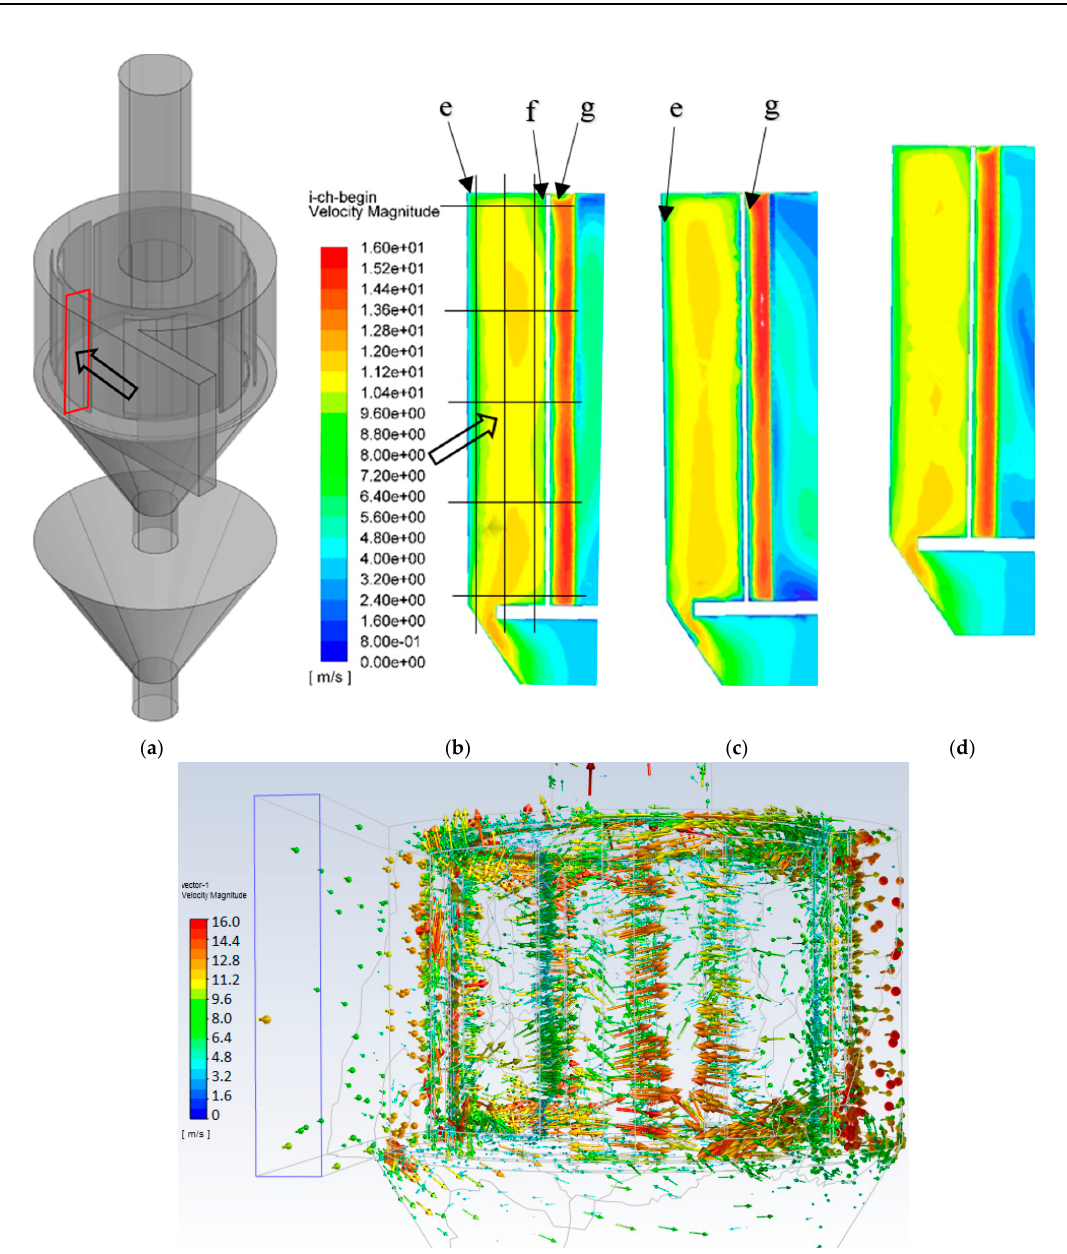
Figure 3. Rate distribution of the gas flow in the developed k ‐ ω SST viscosity model of the multi ‐ channel cyclone separator with a single inlet opening ( a ) at the beginning of the first channel, given for minimally ( b ), moderately ( c ) and maximally ( d ) detailed computational meshes: ( e ) is the wall layer by the peripheral wall; the wall layer near the outer ( f ) and inner ( g ) surfaces of the first curved element, and gas flow velocity vectors colored by rate magnitude, given for maximally detailed computational mesh using k ‐ ω SST viscosity model ( h ).